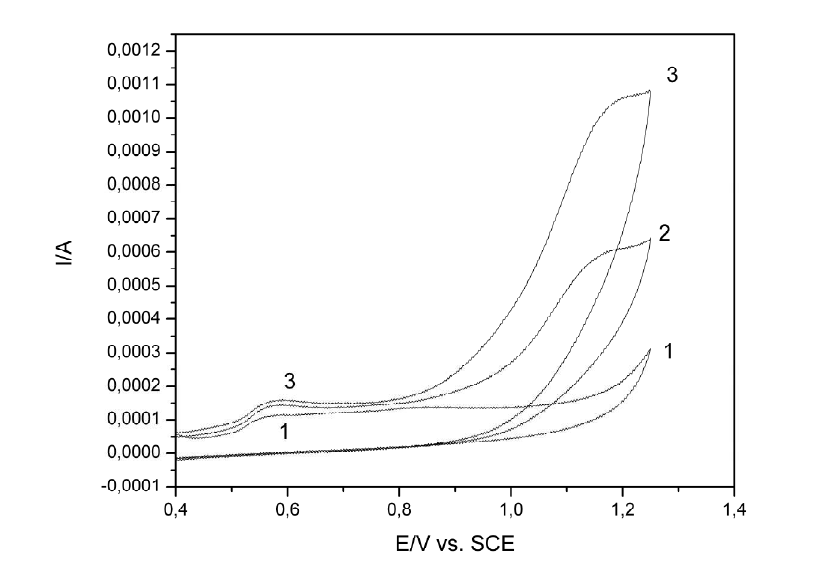
Figure 2. Cyclic voltammograms (3 rd scan ) of the EG-PS electrode in 0.1 M Na 1) and in the presence of 0.5 mM (curve 2) and 1 mM oxalic acid (curve 3); potential scan rate 0.05